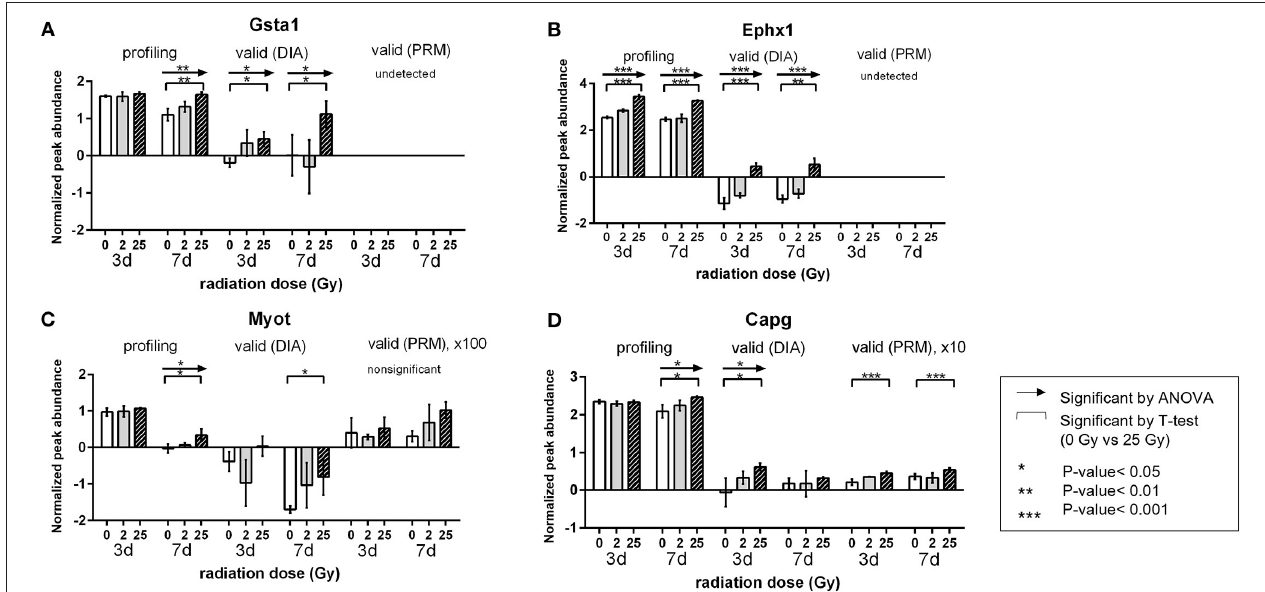
FIGURE 5 | Validation results of the candidate proteins. Changes in expression of each protein by radiation dose and timepoint. Comparison was done within each validation method. (A) Gsta1 (B) Ephx1 (C) Myot (D) Capg. Relative amount is a value of log 2 normalized quantified in profiling and DIA method. * P < 0.05, ** P < 0.01, *** P <